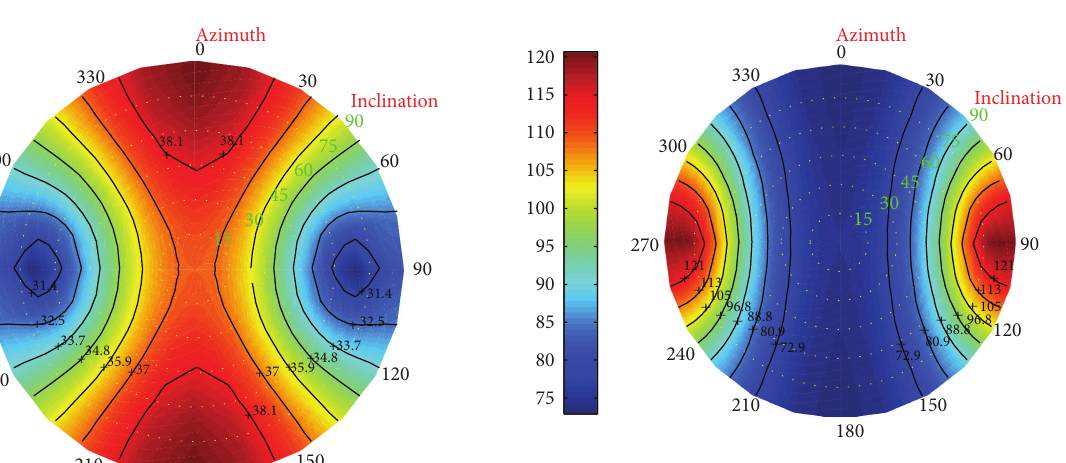
Figure 27: Risk distribution of fracture pressure when temperature drop is 25 ∘ C.